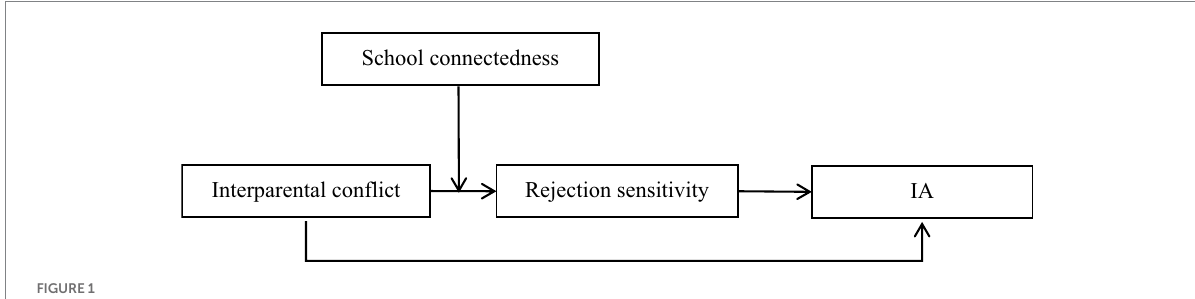
FIGURE 1 The proposed moderated mediation model.